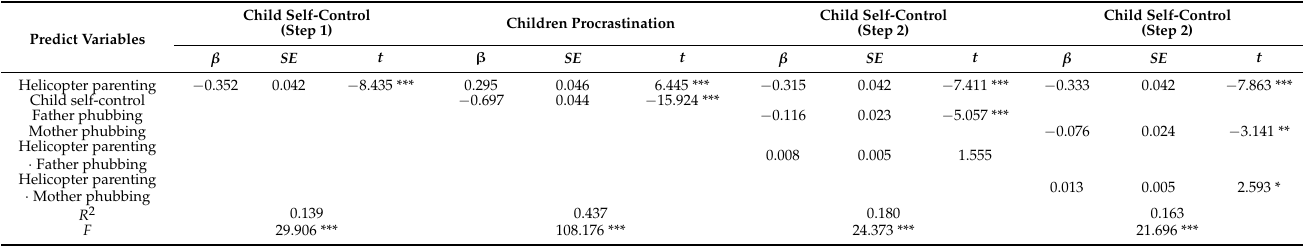
Table 4. Tests for moderating effects of parental phubbing.